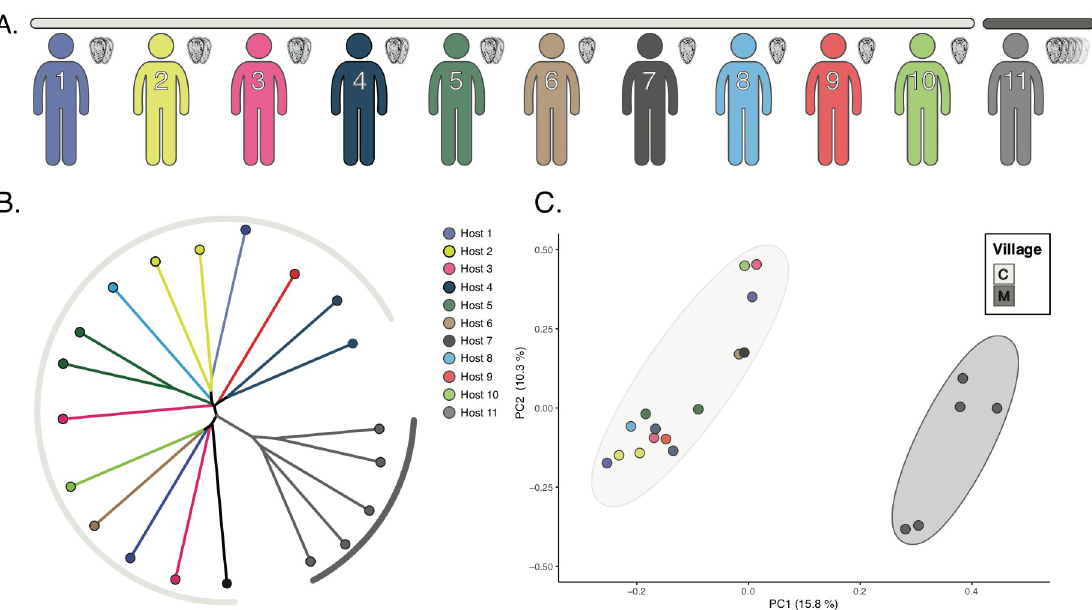
Fig 1. Overview of sampling and genetic separation between villages. A) Number of samples from each host with host identification labeled within colored human silhouettes. Village identification is indicated by the colored bars overhead that correspond to the figure legend in panel C. B) Neighbor Joining tree using all exonic variants from all miracidia, excluding the two samples with particularly low mapped read percentages. C) Principal Component Analysis of all exonic variants with the first principal component representing 15.8% of the variation and the second representing